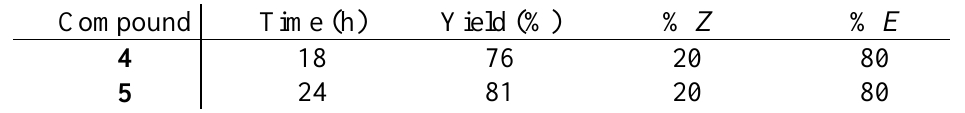
Table 1 :Time(h), yield(%) and isomer ratios of compounds (4-5).